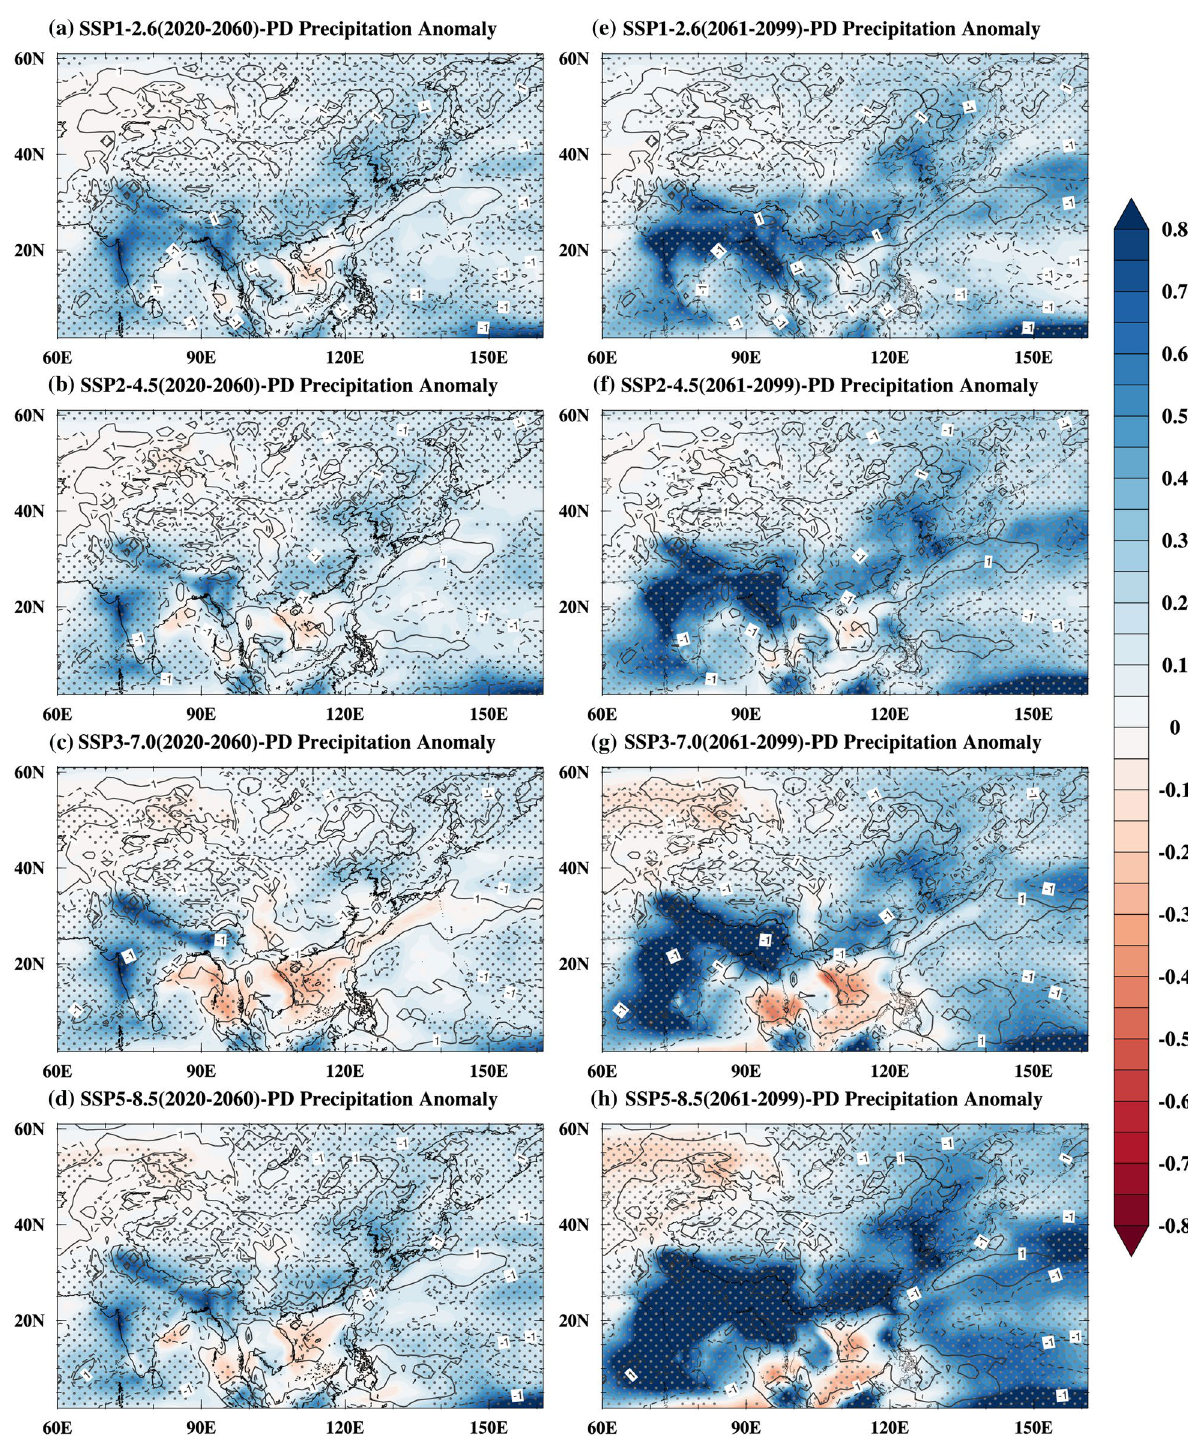
Figure 7. The summer precipitation anomalies (unit: mm/day, shading) together with vertical potential anomalies (unit: 10 –3 Pa/s, dashed (solid) lines indicate upward (downward) motions) at 500 hPa for 2020–2060 (near-term, a – d ) and 2061–2099 (late-term, e – h ) under the SSP1-2.6 ( a , e ), SSP2-4.5 ( b , f ), SSP3-7.0 ( c , g ), SSP5- 8.5 ( d , h ) relative to the present day. The grey dots indicate a 5% of significance level. Maps were generated using the NCAR Command Language (The NCAR Command Language (Version 6.6.2) [Software]. (2019). Boulder, Colorado: UCAR/NCAR/CISL/TDD. https:// www. ncl. ucar. edu/ Downl